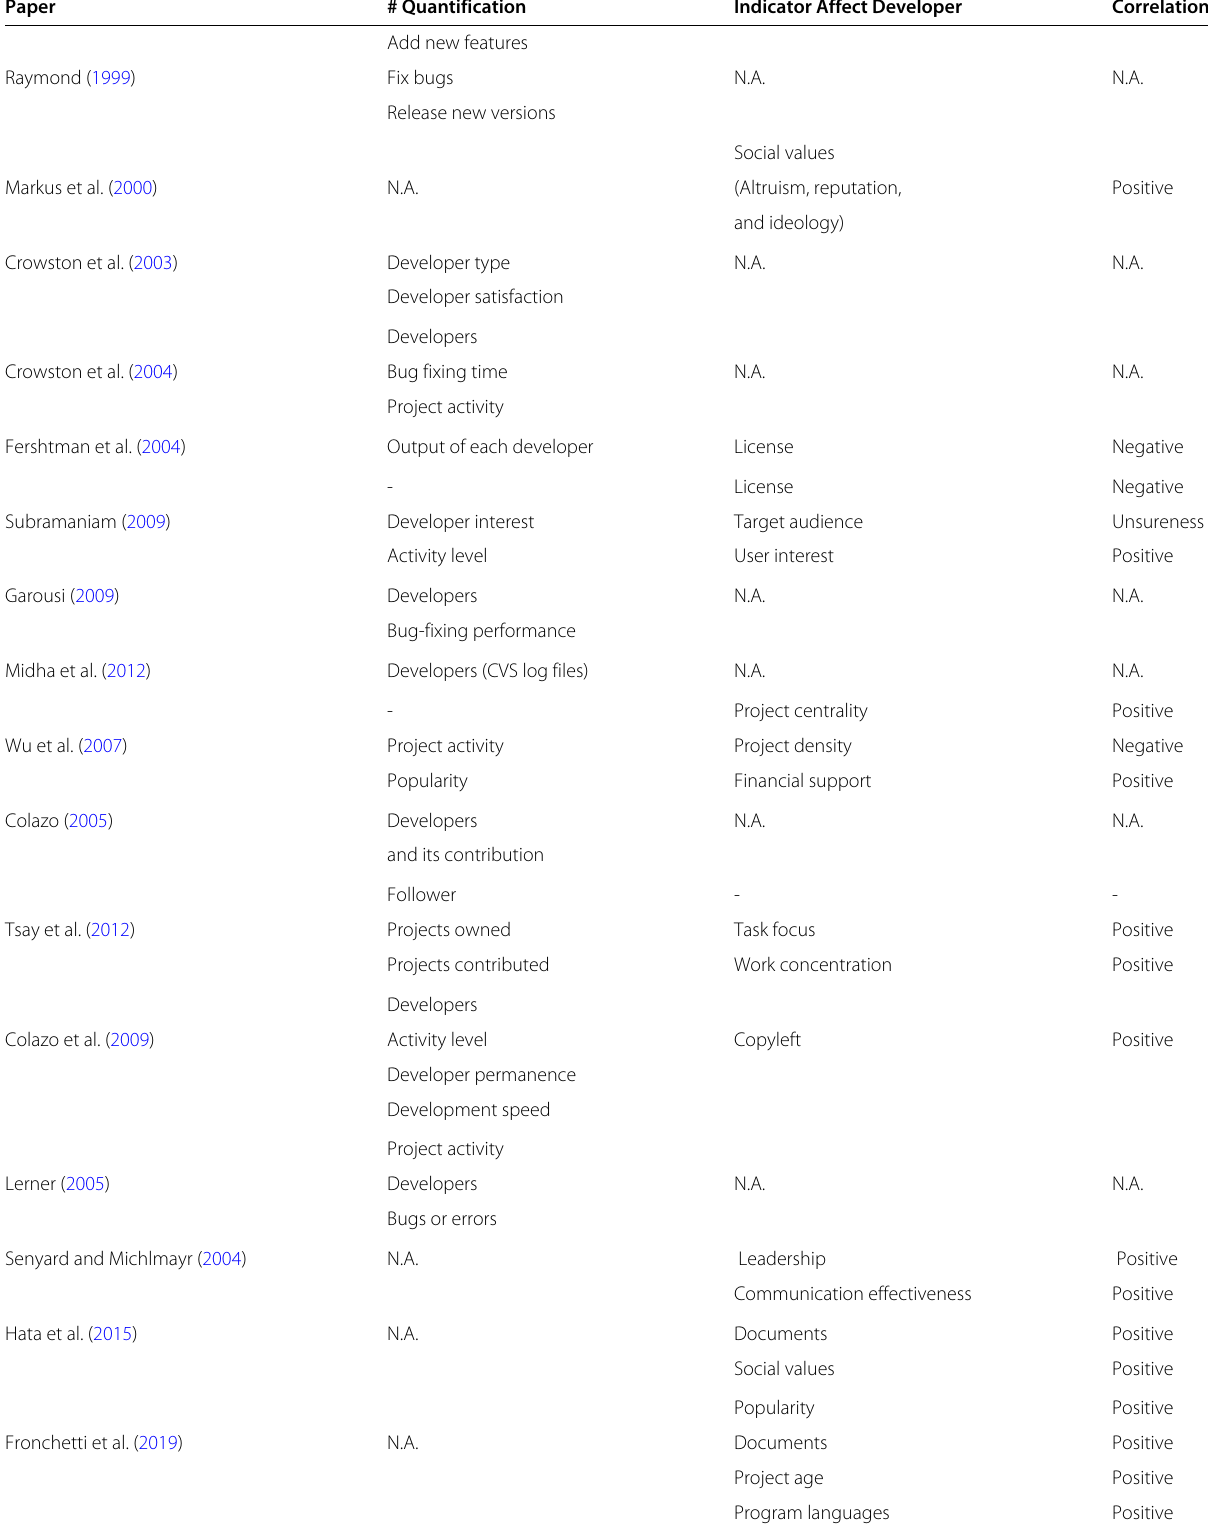
Table 6 The indicators about